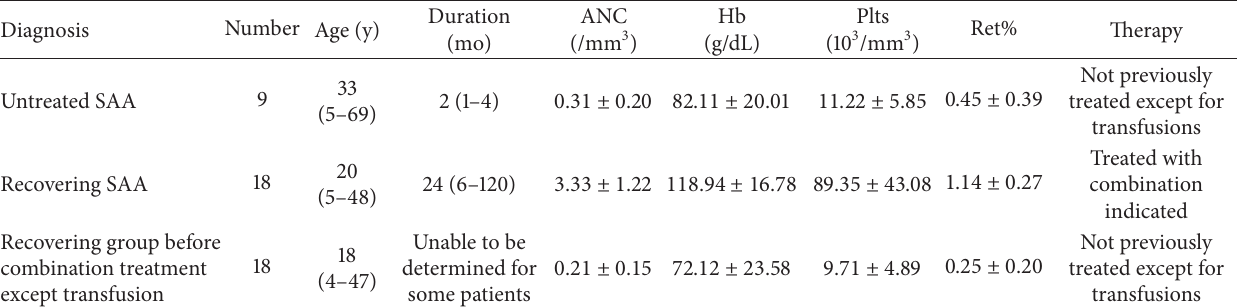
Table 2: Clinical and demographic parameters of patients participating in the